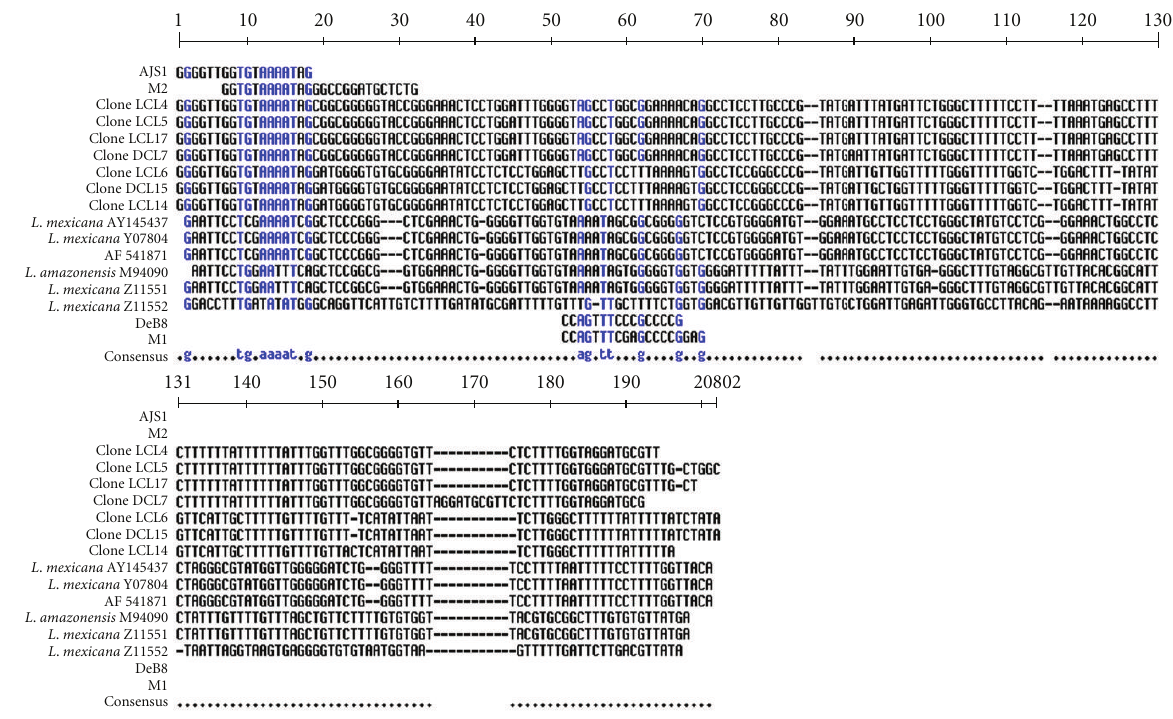
Figure 5: Aligment of the kDNA minicircles sequences classes (from 1 to 200bp). Clones of the Mexican isolates: LCL4, DCL7, LCL17, DCL15, LCL6, and LCL14. Sequences of other members of the Leishmania mexicana complex published in the GeneBank: L. mexicana Y07807, AF54187, Y145437; L. (L.) amazonensis M 94090; L. (L.) mexicana Z11551, Z11552, Z11554, Z11556, and Z11549; L. (L.) amazonensis M21325, M 21327; L. (L.) mexicana Z11553, Z11555.